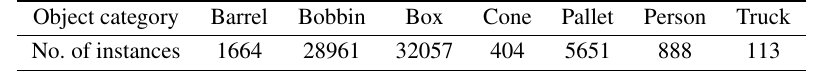
Table 1. Details of the annotated objects in the synthetic dataset